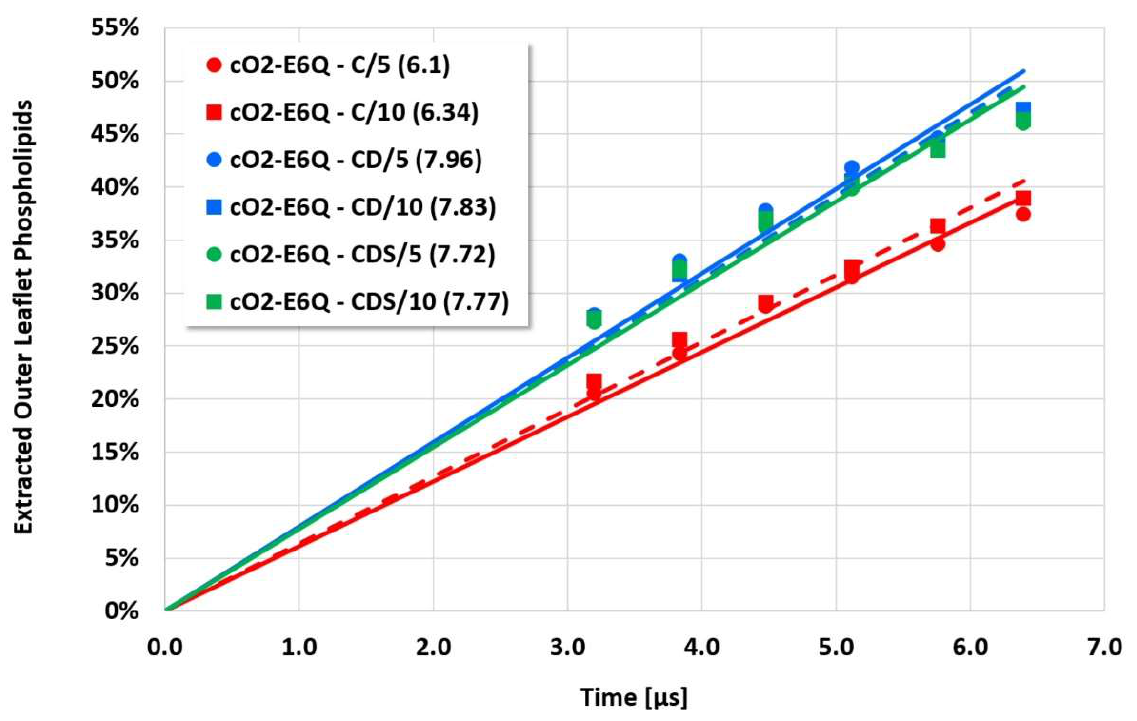
Figure 7. Cyclotide/membrane system cO2-E6Q/NoC-PM (see Figure 4 for details).